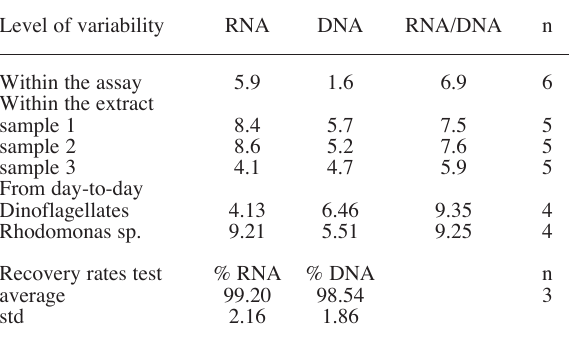
T ABLE 2. – Upper part: Precision of the final procedure evaluated at different levels of variability and expressed as the coefficient of variation, CV(%) = (standard deviation/average) x 100, of the esti- mations of RNA and DNA concentrations and their resulting RNA/DNA ratios. Lower part: Accuracy of the method approached through the recovery rates test, expressed as the proportion (in %) between the measured and expected RNA and DNA concentrations of the spiked standards.